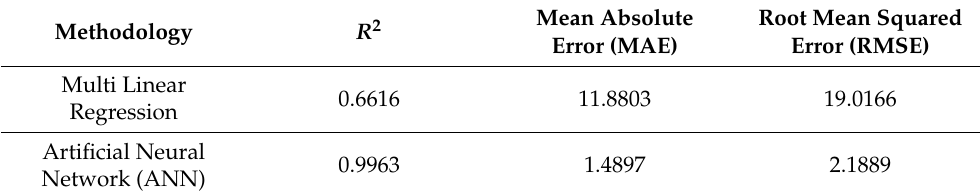
Table 3. Performance measures of each methodology.